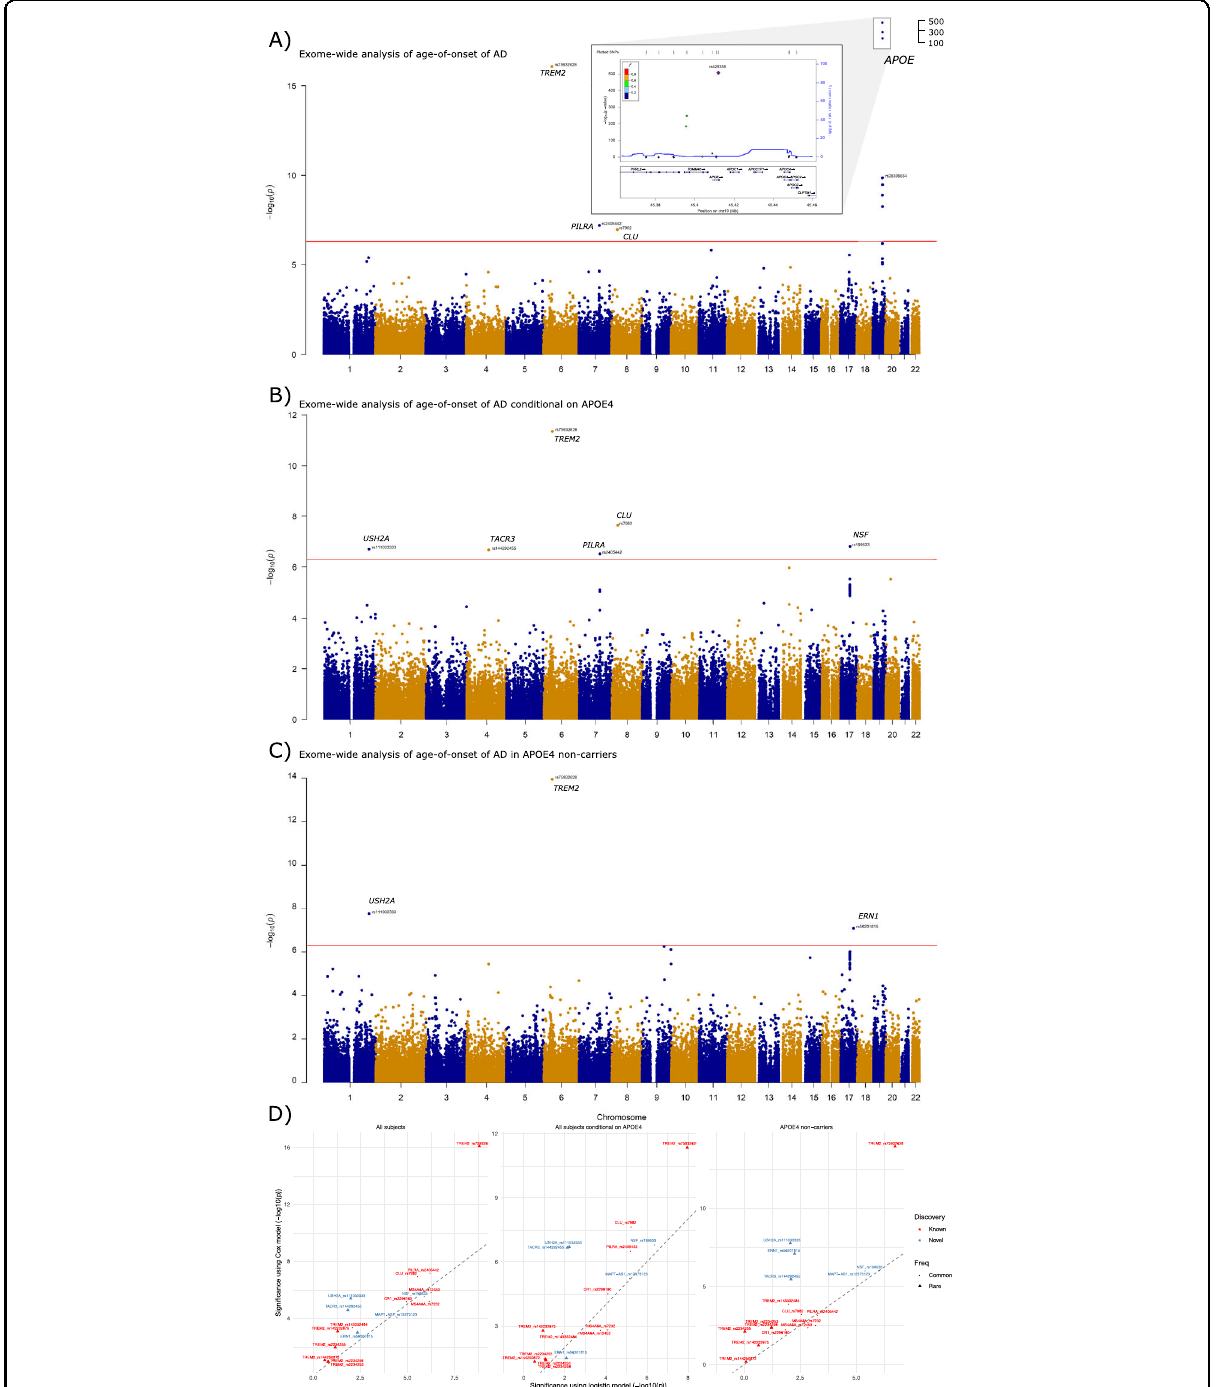
Fig. 1 Results of exome-wide association analyses of age-of-onset of AD in the ADSP sample. A Model 1: a Cox model with all subjects adjusted for three signi fi cant PCs and sex; B Model 2: a Cox model with all subjects adjusted for the copies of APOE ε 4 , three signi fi cant PCs and sex; C Model 3: a Cox model with APOE ε 4 non-carriers adjusted for three signi fi cant PCs and sex. Three top SNPs identi fi ed in the APOE region using Model 1 were highlighted in the regional plot due to their extremely signi fi cant p -values. The red horizontal line is a threshold based on the Bonferroni correction (0.05/100,000 = 5E − 07). D Comparison of p -values between a Cox model and a logistic model for well-known AD-related SNPs and newly identi fi ed SNPs in this study in Model 1 (left), Model 2 (middle), and Model 3 (right). The same ADSP data and covariates were used to fi t the Cox and logistic